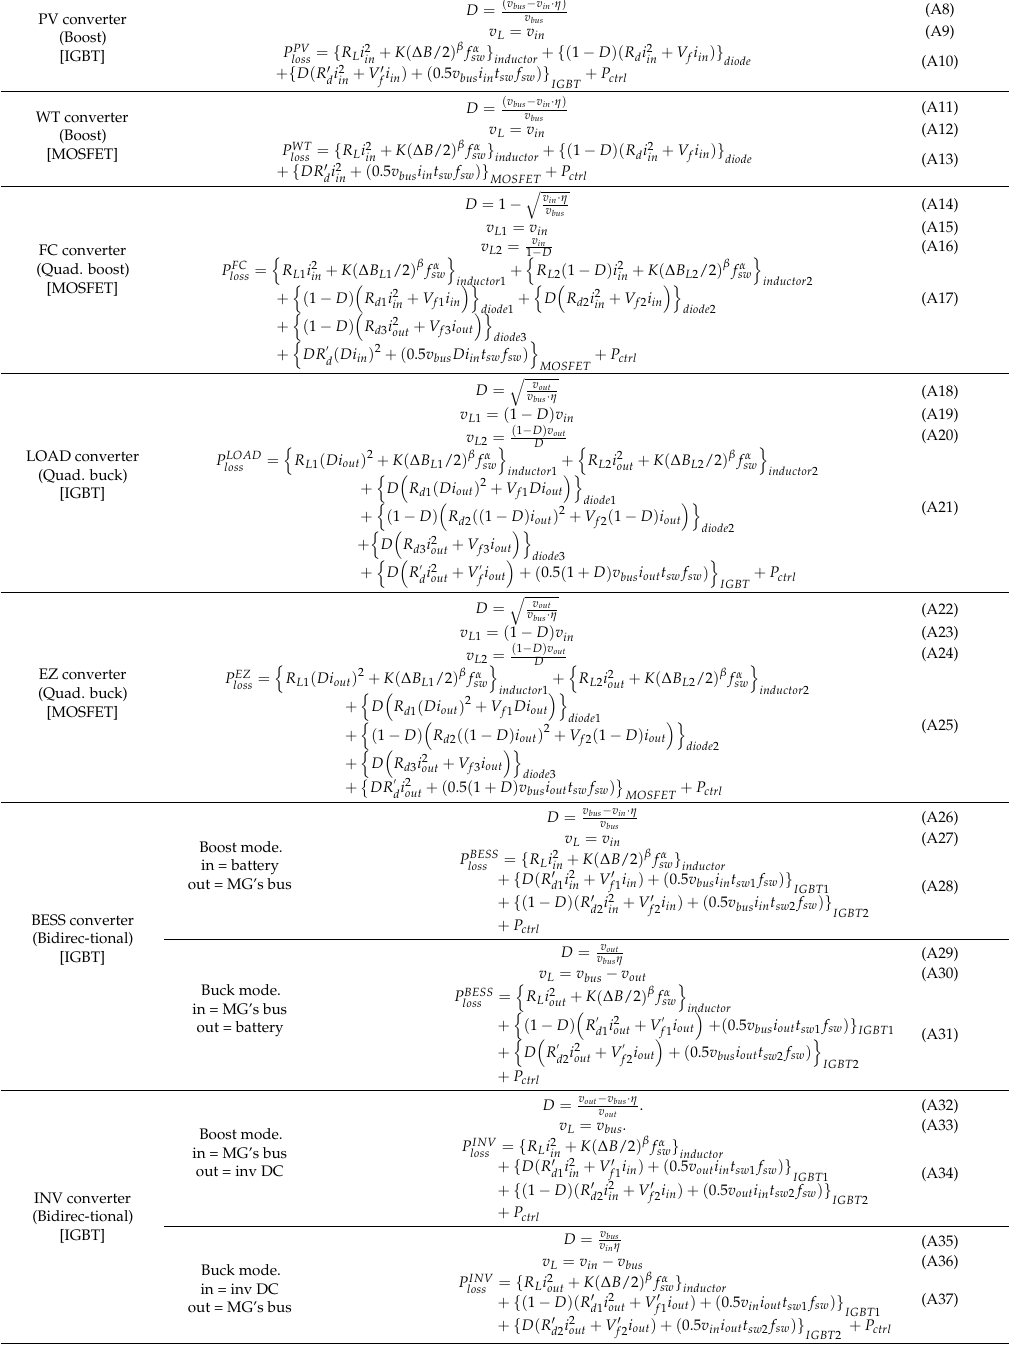
Table A2. Equations utilized to model the converters’ power